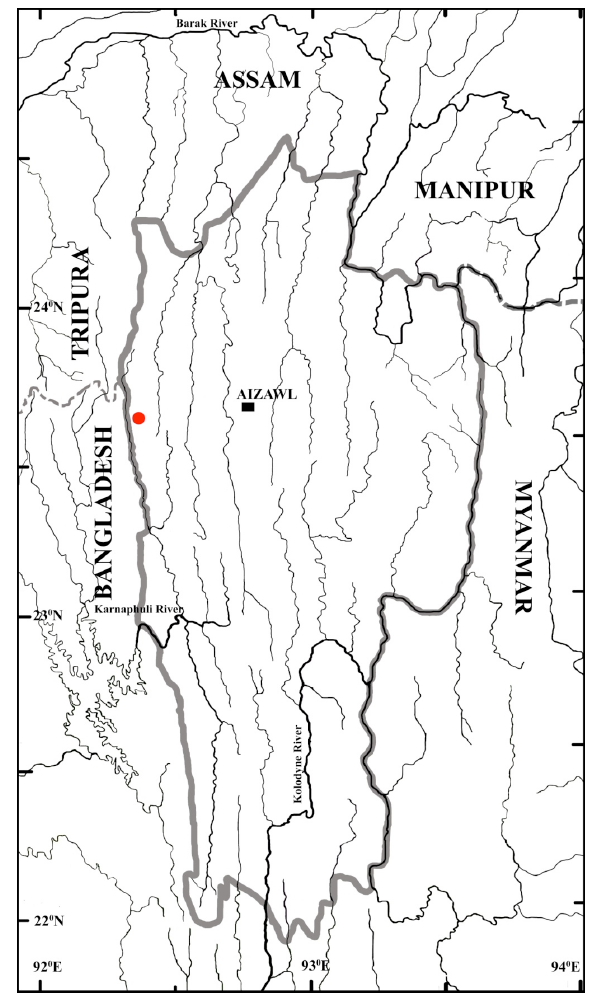
Figure 1. Map of Mizoram, India showing collection localities of ( ● ) Garra dampaensis sp. nov. A symbol may represent more than one